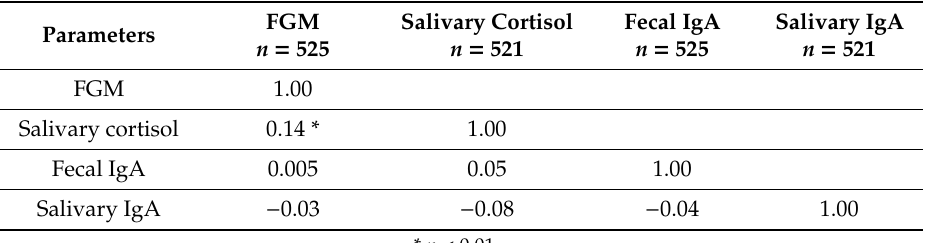
Table 4. Association matrix with GC and IgA in saliva and fecal samples.